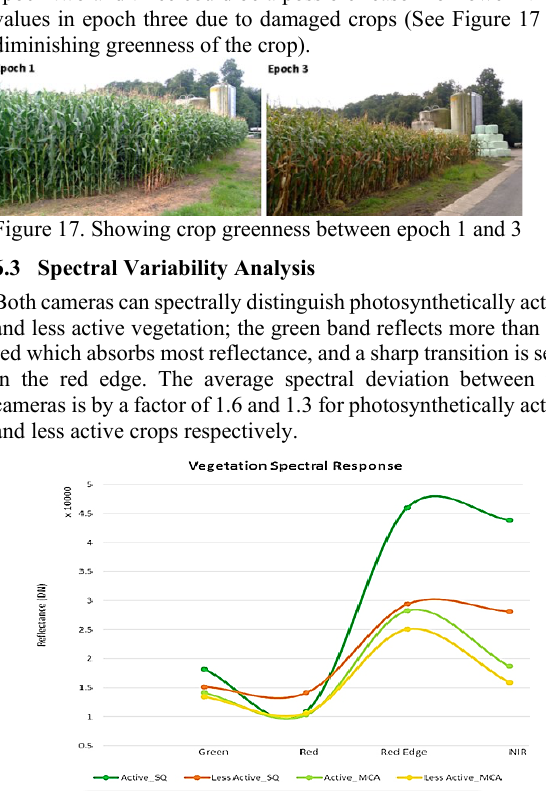
Figure 18. Spectral analysis of Sequoia and Micro MCA